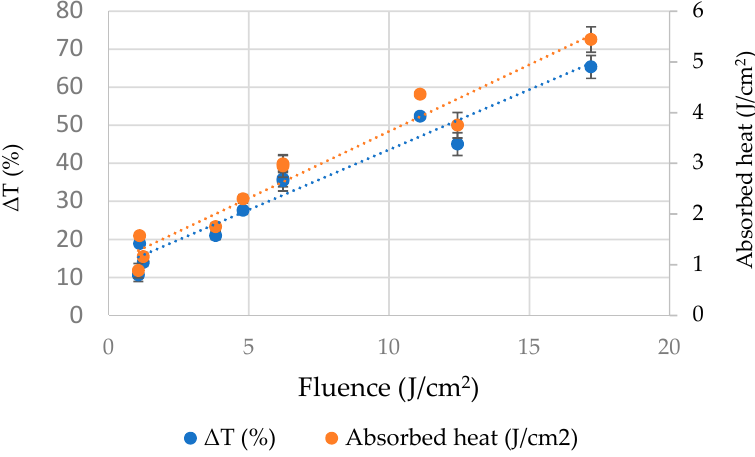
Figure 2. The impact of PL on temperature increment of gallic acid aqueous solution.